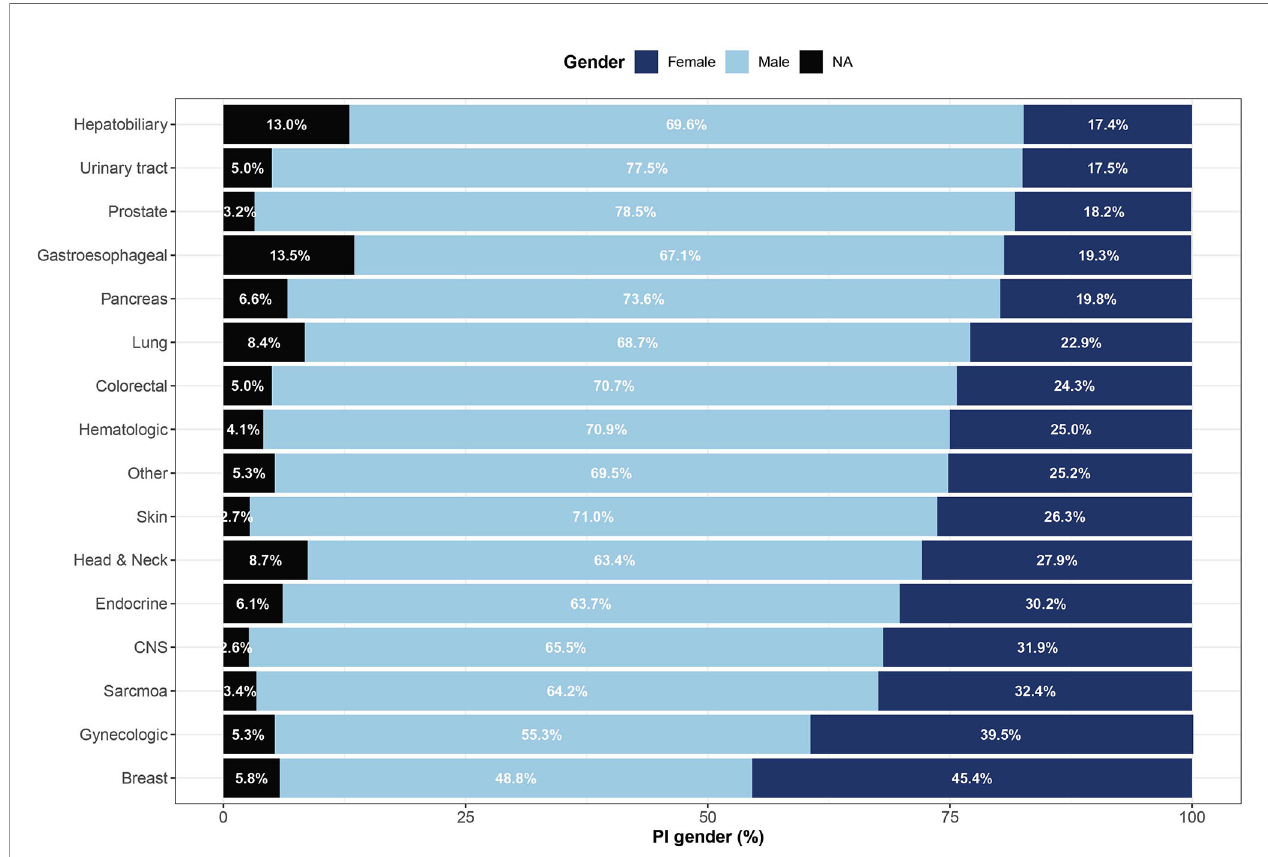
FIGURE 2 | Representation of women among lead investigators of oncology clinical trials by cancer site. Shown are gender proportions of principal investigators leading studies of 16 cancer sites. Names with low gender prediction scores or names for which gender could not be determined are marked as not applicable (NA). CNS, central nervous